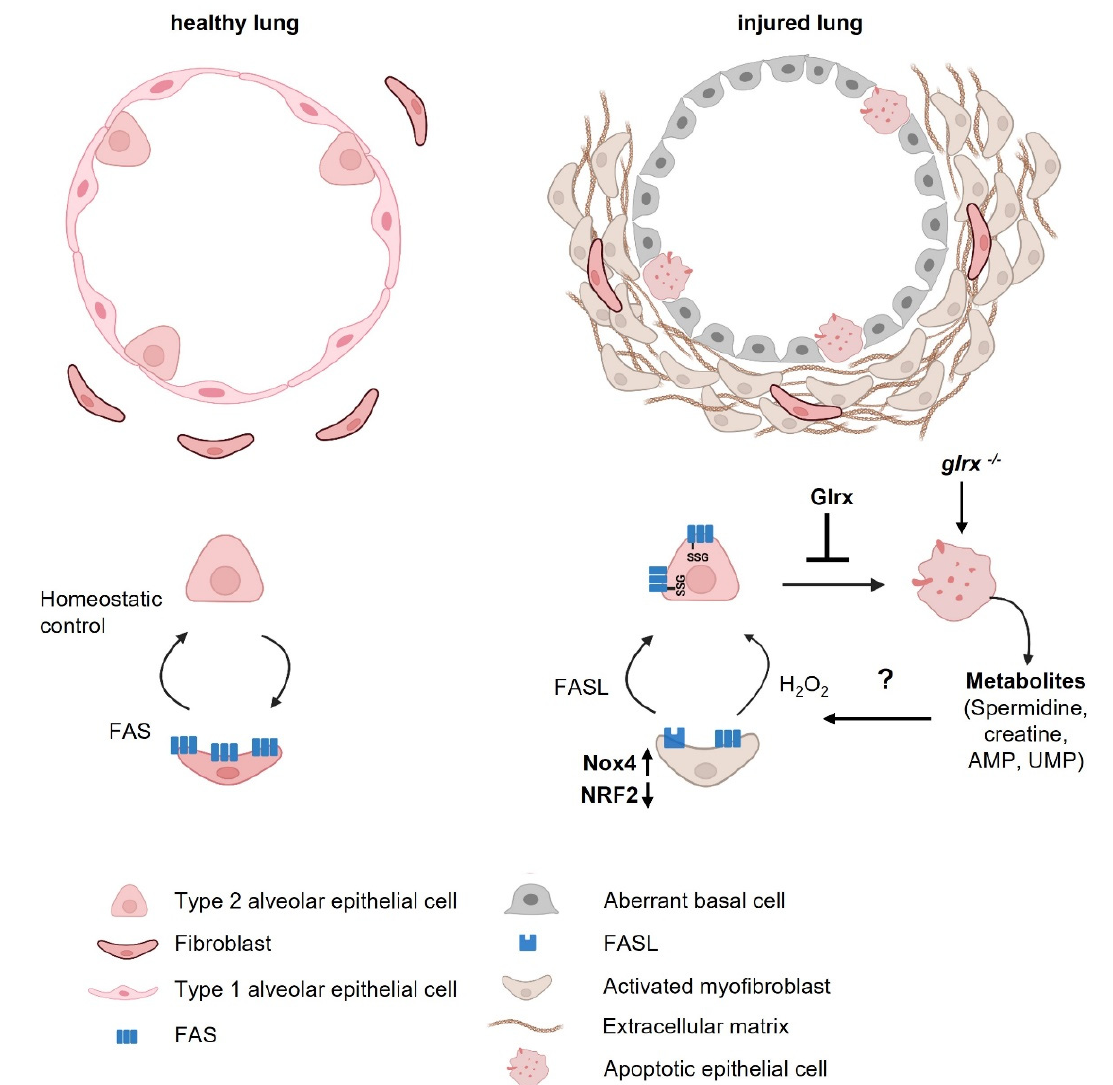
Figure 3. Schematic overview of disrupted epithelial-fibroblast homeostasis in pulmonary fibrosis. Left: top—depiction of the healthy alveolus lined with alveolar type 1 (AT1) cells interspersed with alveolar type 2 (AT2) progenitor cells and sporadic fibroblasts. Bottom—homeostatic control between AT2 cells and fibroblasts. Right: top—depiction of a disrupted alveolus in pulmonary fibrosis showing loss of AT1 cells, dying AT2 cells, emerging aberrant basal cells, activated fibroblasts, and excessive deposition of extracellular matrix. Bottom—disrupted crosstalk between AT2 cells and fibroblasts in fibrosis. Enhanced FASL and NOX4 expression in fibroblasts and secretion of H 2 O 2 promote killing of alveolar epithelial cells, while the diminished FAS expression on activated myofibroblasts conversely promotes their apoptosis-resistance. Enhanced FAS-SSG on epithelial cells promotes their death, which can be ameliorated by the deglutathionylase, GLRX. Additionally depicted is the GLRX-sensitive production of apoptosis-associated metabolites in dying alveolar epithelial cells. Future studies should address the impact of apoptosis-associated metabolites in the emergence of aberrant basal cells and myofibroblasts and the disrupted cross talk between epithelial cells and fibroblasts. This image was generated using Biorender.